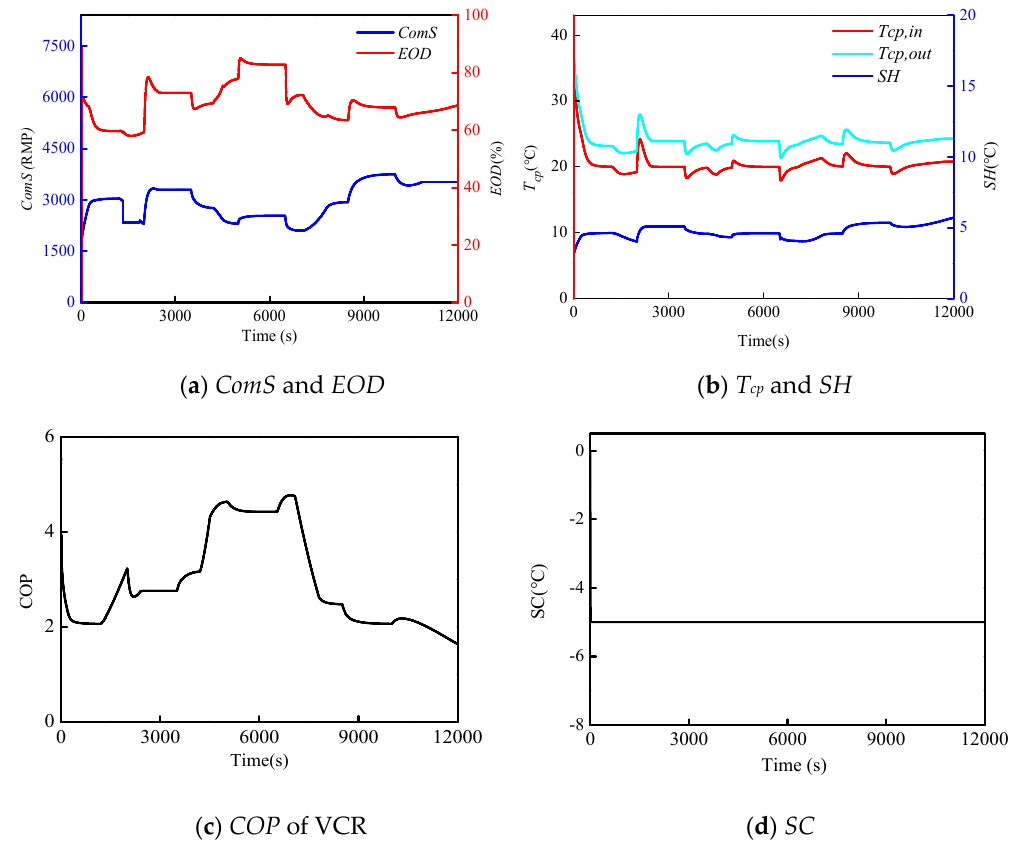
Figure 17. Control results in a hot day.